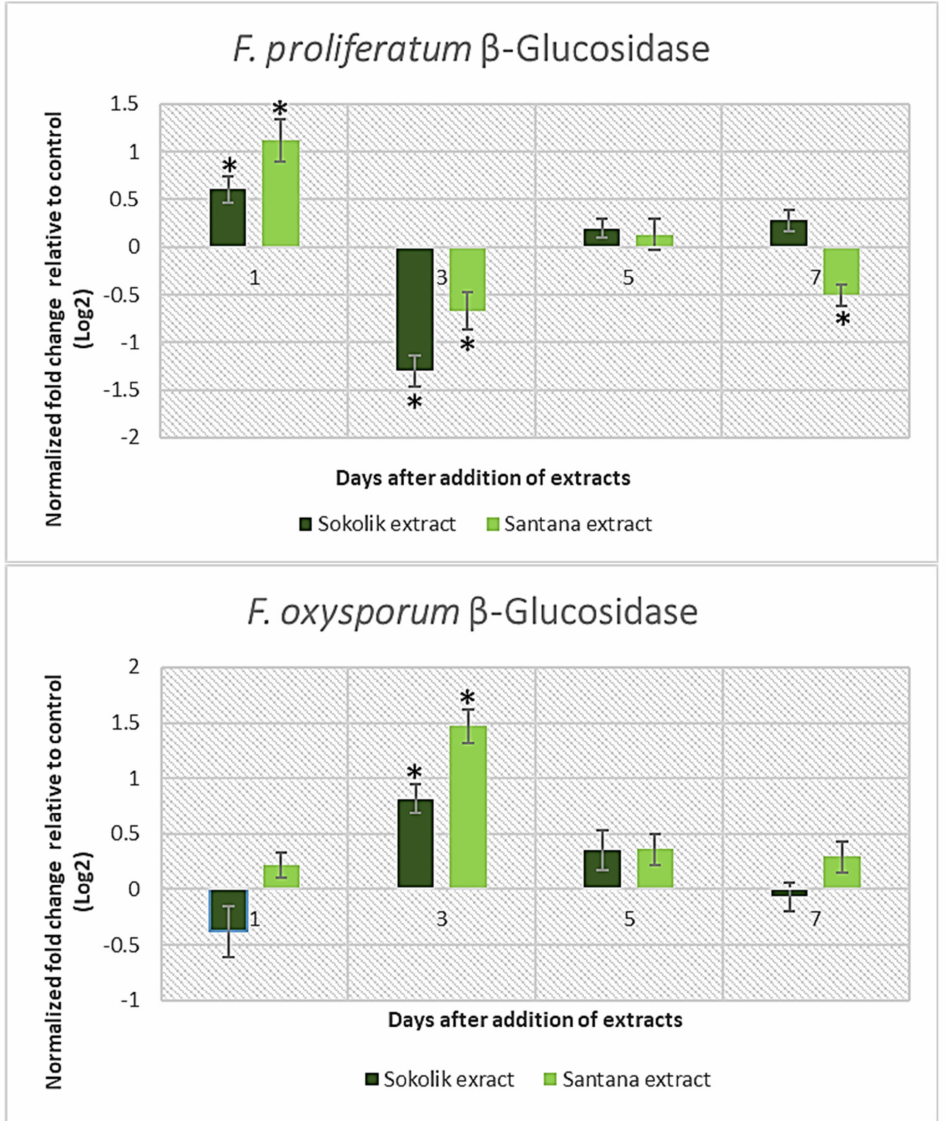
Figure 1. β − Glucosidase gene expression of F. proliferatum (PEA1) and F. oxysporum (1757 OX) from day 1 to day 7 after the addition of the Sokolik and Santana extracts. Error bars represent the standard error. * Statistically significant ( p <